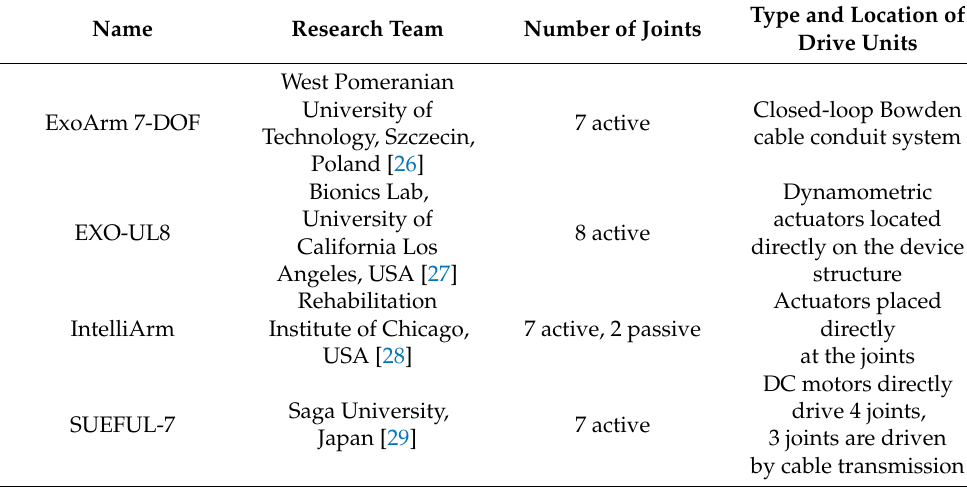
Table 4. The most advanced exoskeleton structures supporting the elbow